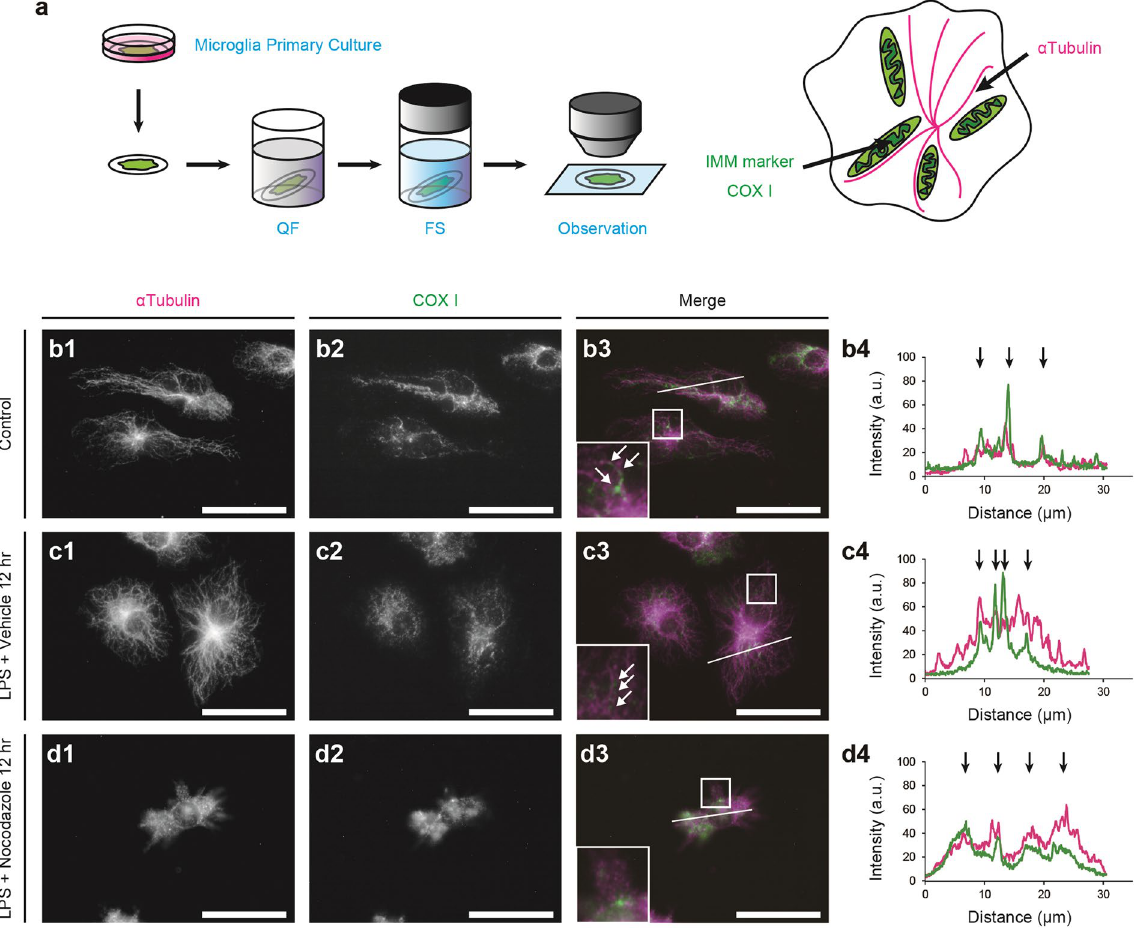
Figure 5. Mitochondrial elongation along microtubules following the stimulation with lipopolysaccharide (LPS). An experimental scheme shows that primary microglial cultures were quickly frozen (QF), freeze- substituted (FS), and immunostained for α -tubulin and the inner mitochondrial membrane (IMM) marker, COX I ( a ). Double immunostaining for mitochondria (COX I) and microtubules ( α -tubulin) in microglia without the LPS stimulation ( b , arrows) or 12 hr after the LPS stimulation ( c , arrows). Areas indicated with rectangles (b3, c3, d3) are shown in the insets. Fluorescence intensity was measured along the lines (b3, c3, d3), and the arrows show the strong fluorescence intensities of α -tubulin (magenta) and COX I (green) at the same locations (b4, c4). Bars: 30 μ